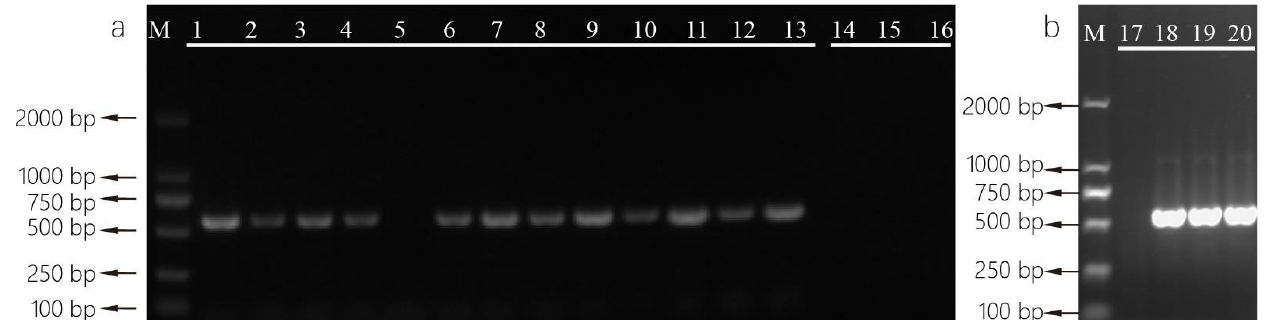
Figure 1. Amplification of rDNA-ITS-region of Aspergillus spp. colonies. Lane M: 2000 bp ladder, lanes 1 – 13: colonies incubated at 95 °C for 10 min, lanes 14 – 16: colonies unincubated, lane 17: negative control, lanes 18 – 20: DNA extracted from A. cristatus , A. chevalieri , and A. pseudoglaucus were used as positive controls.